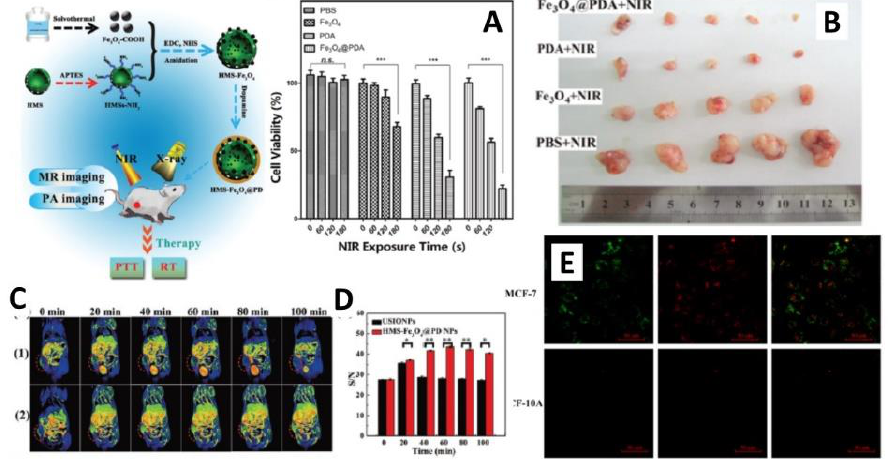
Figure 4. ( A ) Relative viabilities of A549 cells treated with Fe 3 O 4 , PDA, and Fe 3 O 4 @PDA at a concentration of 50 µ g mL − 1 without or with NIR laser irradiation; ( B ) Photograph of tumors after excision from PBS, Fe 3 O 4 , PDA, and Fe 3 O 4 @PDA under NIR irradiation (reproduced with permission from ref. [88]. Copyright 2015 ACS Publications); ( C ) T 1 -Weighted MR imaging of xenograft 4T 1 tumors in mice before and at different time points post intravenous injection of ultrasmall iron oxide nanoparticles (USIONPs); ( D ) MR signal/noise (S/N) ratios of tumors at different time points (reproduced with permission from ref. [28]. Copyright 2013 Royal Society of Chemistry); ( E ) Simultaneous detection of multiple mRNAs in living cells (reproduced with permission from ref. [39]. Copyright 2014 ACS